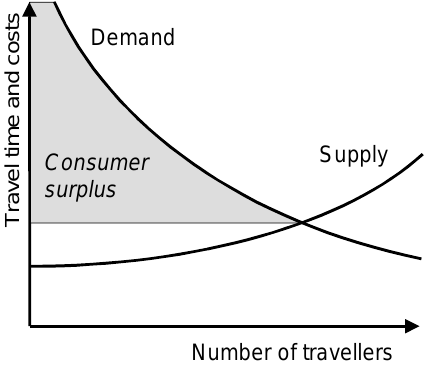
Figure 1. The concept of consumer